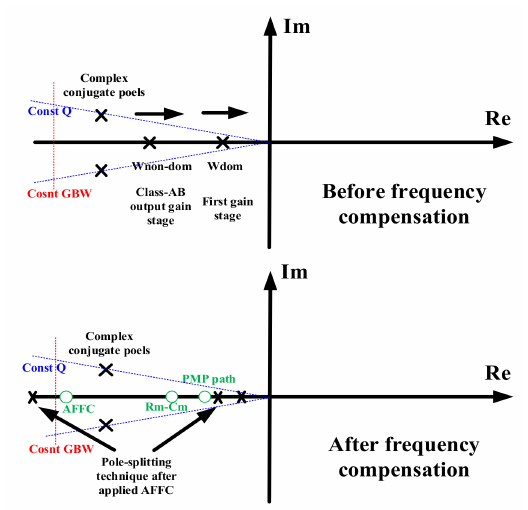
Figure 7. The pole-zero location diagram for illustrating frequency compensation.